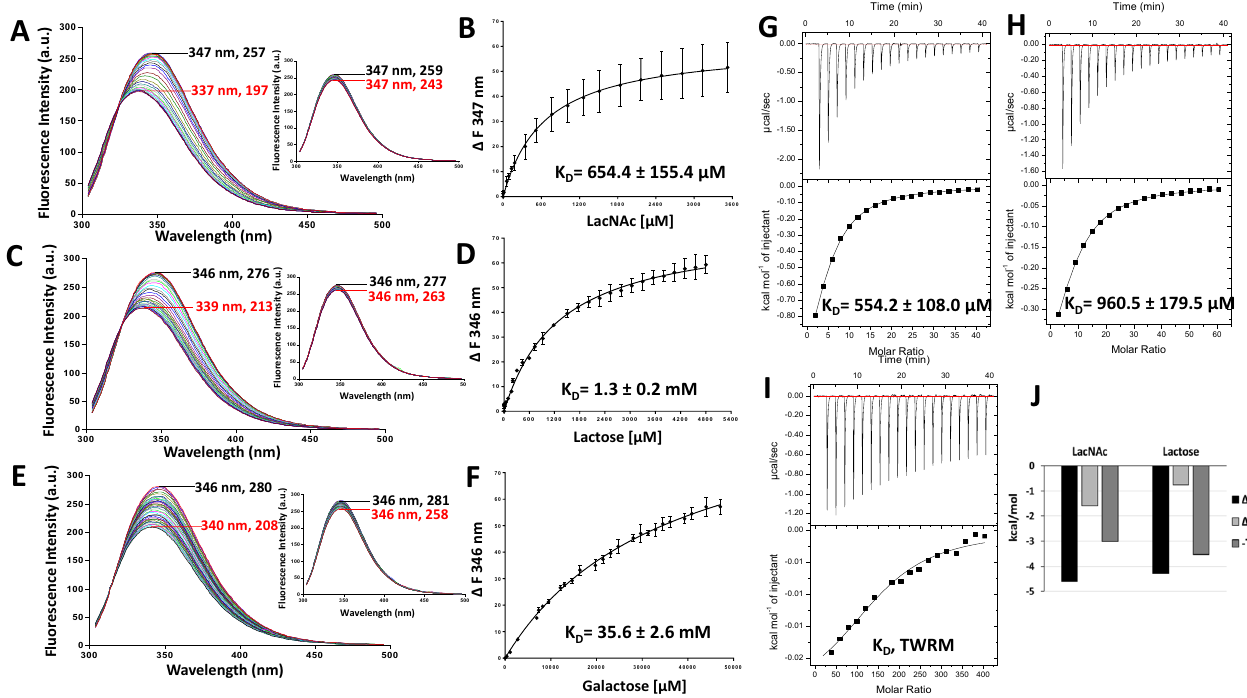
Figure 4. Determination of galectin-2-ligand interaction by TFS and ITC. Galectin-2 (20 µ M) florescence intensity with increased concentrations of LacNAc ( A ), lactose ( C ) and galactose ( E ) were recorded by fluorescence spectroscopy. Numbers indicate the maximum fluorescence wavelength and corresponding fluorescence intensity for the first (no ligand/buffer titration, black) and last (red) titration traces. Inserts in each figure show buffer control titrations. Ligand concentrations vs changes in fluorescence intensity were plotted and analysed using One site- Specific binding model to obtain the binding affinities to LacNAc ( B ), lactose ( D ) and galactose ( F ). Heat changes for titration of galectin-2 (100 µ M) with 20 mM LacNAc ( G ), 30 mM lactose ( H ) and 200 mM galactose ( I ) were measured by ITC (upper panels) with data fitting to One set of sites interaction model (bottom panels). Data were plotted as means ± SEM from three independent experiments for each assessment. (TWRD, too weak to be reliably determined). Panel (J) shows thermodynamic profiles with enthalpy ( ∆ H), entropy ( ∆ S) and Gibbs free energy ( ∆ G) changes associated with galectin-2 binding to LacNAc and